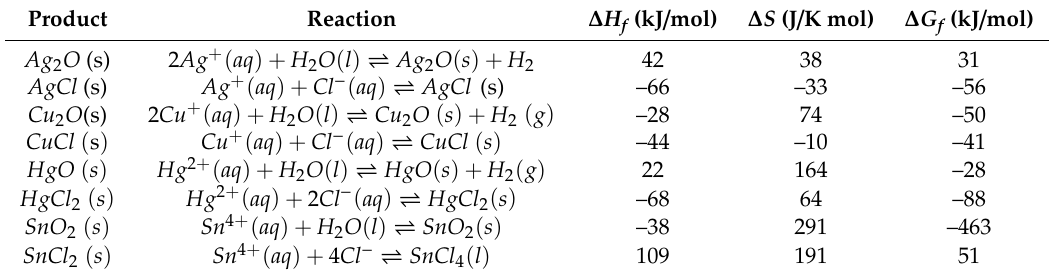
Table 7. Thermodynamic calculations for the formation of key oxides and